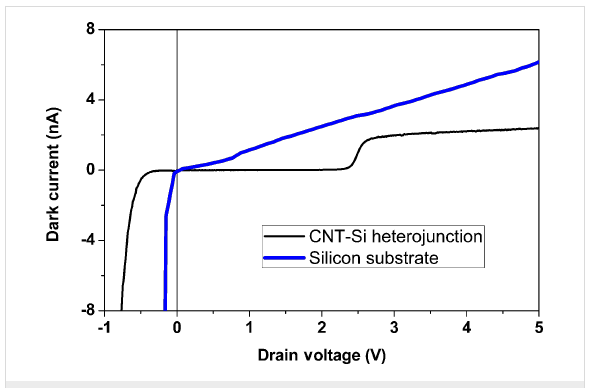
Figure 3: Dark current comparison of the Si substrate and the CNT–Si